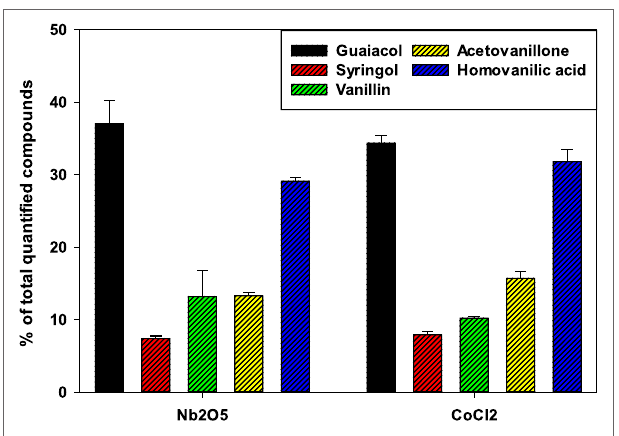
FigUre 6 | Distribution of quantified products in the extracted oil using Nb 2 O 5 and CoCl 2